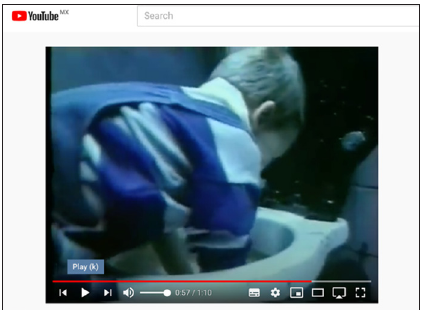
Figure 5: Toilet. TV and cinema ad to eliminate Third World debt (Trott,